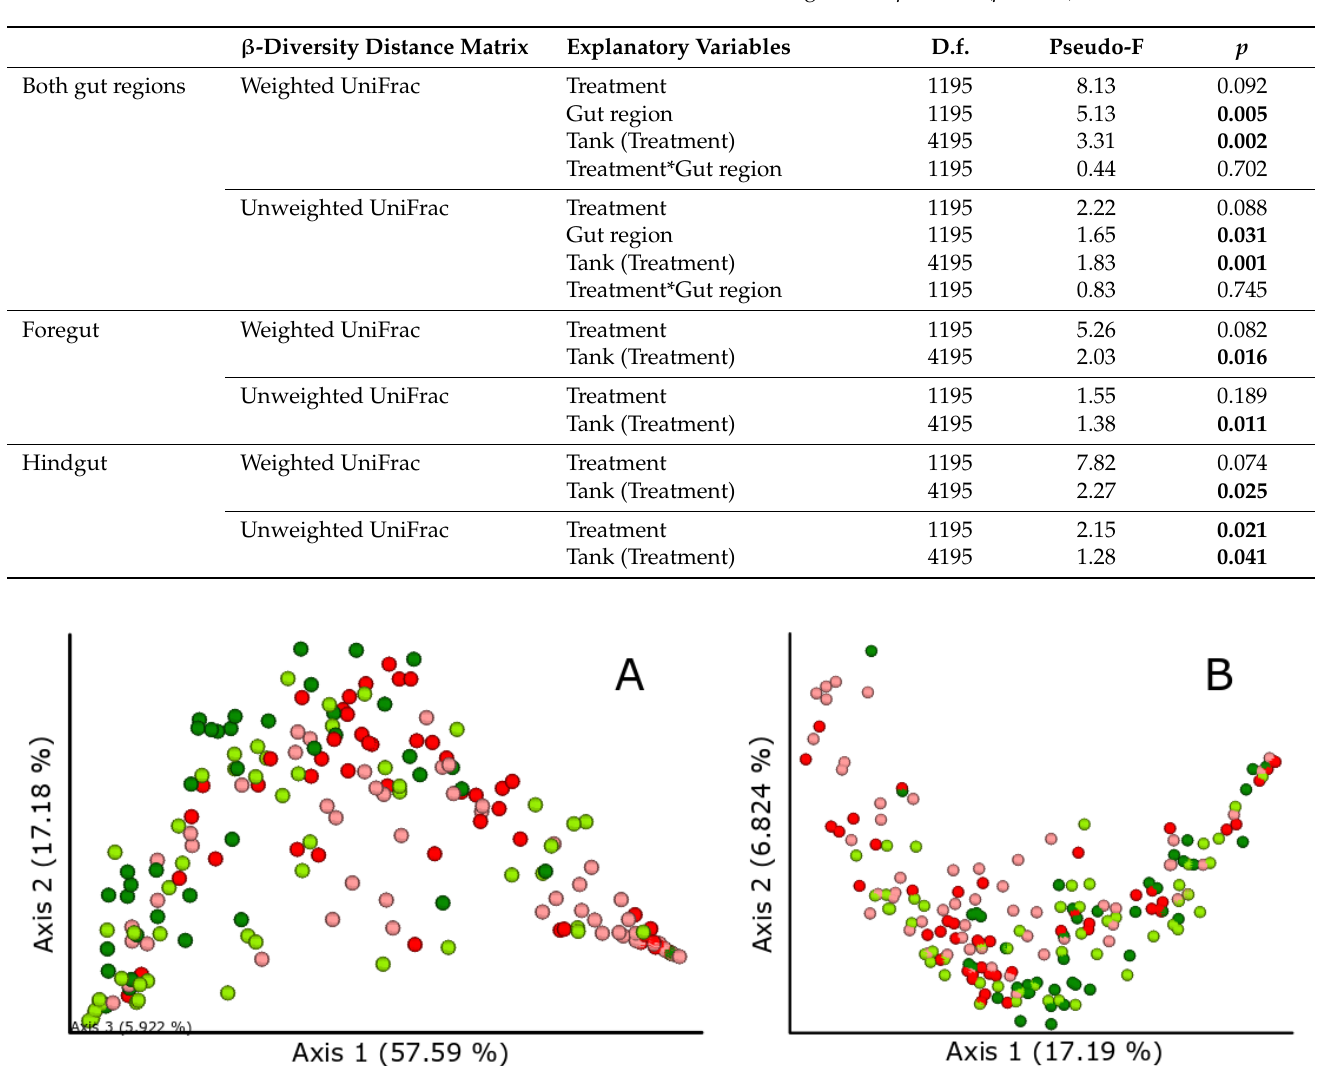
Table 2. General linear mixed models exploring the effects of treatment, gut region, tank nested in treatment, and the interaction of treatment and gut region in beta diversity indices of the bacterial community of gilthead seabream juveniles fed with control diet or supplemented with Allium -derived PTSO. D.f. refers to degree of freedom. The first number is the degree of freedom of the independent variable, and the second is for the error term. Significant p -values ( p < 0.05) are shown in bold.